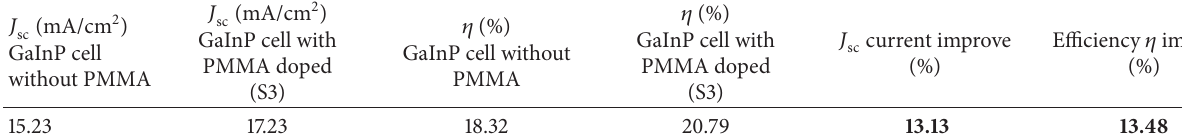
Figure 5: Simulation results of (a) the short-circuit current density and conversion efficiency variation with the number of dyes added and (b) the increase in the short-circuit current density and conversion efficiency variation with the number of dyes added. Table 4: Short-circuit current density and efficiency of the GaInP solar cell with and without LDS.